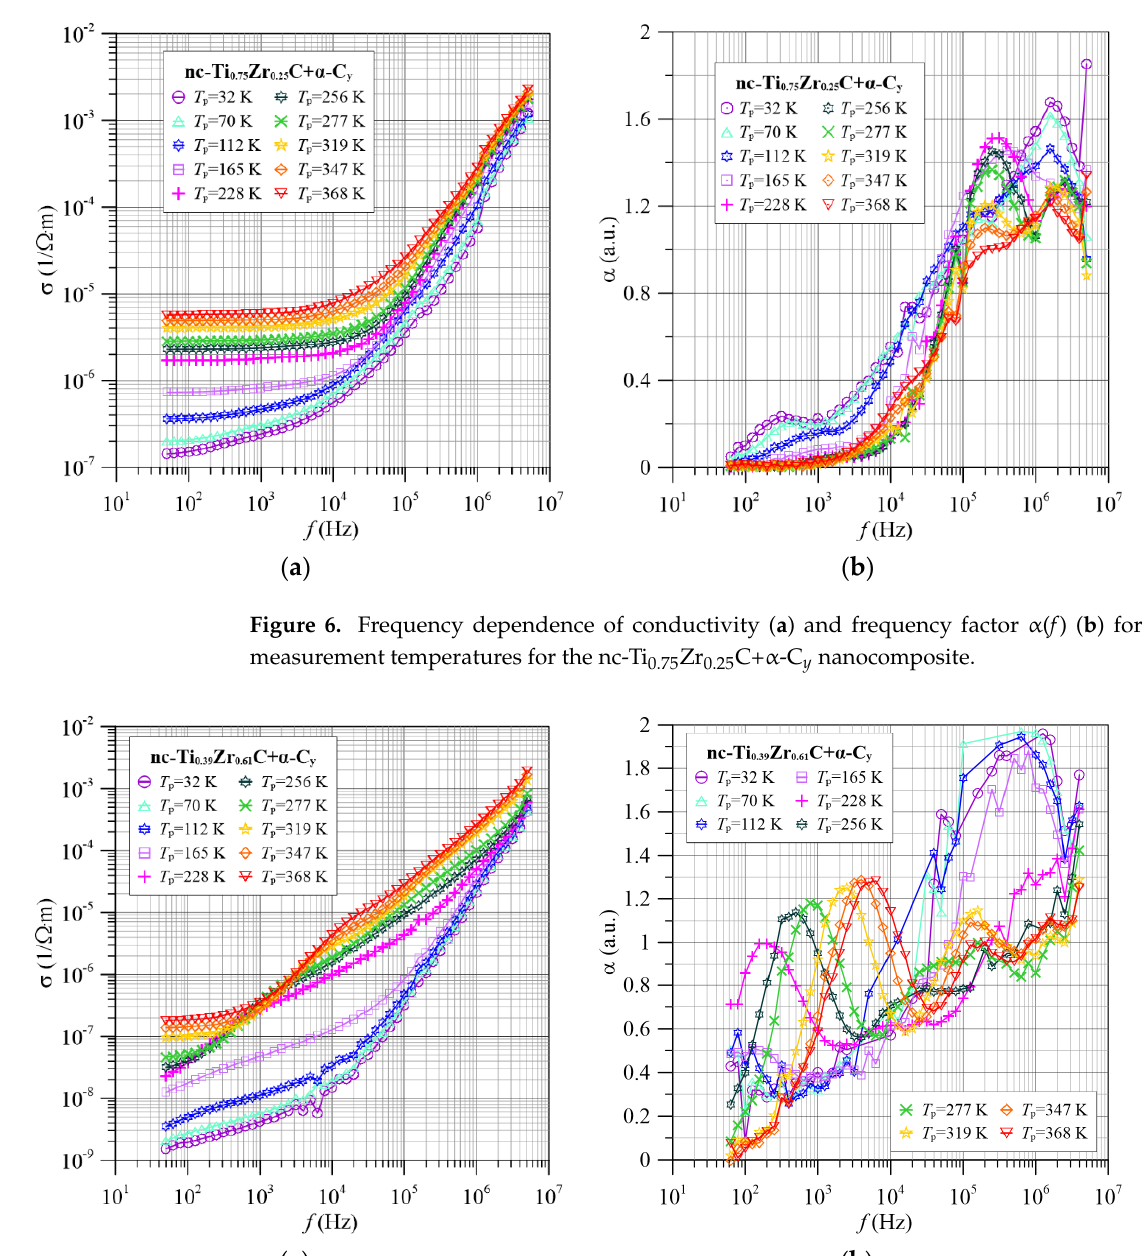
Figure 5. Frequency dependence of conductivity ( a ) and frequency factor α ( f ) ( b ) for selected meas ‐ urement temperatures for the nc ‐ Ti 0.86 Zr 0.14 C+ α‐ C y nanocomposite.